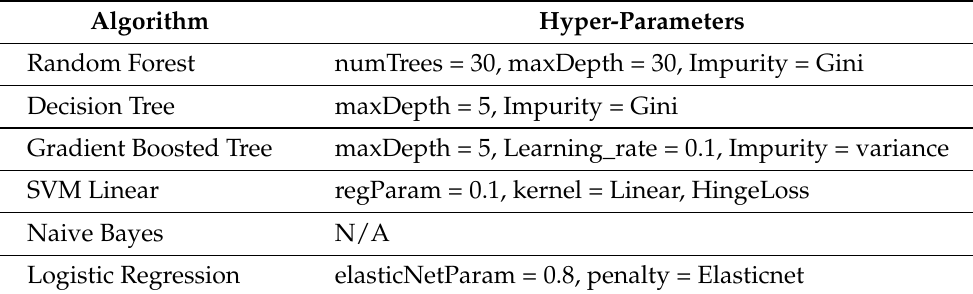
Table 1. Algorithms Hyper-Parameters.